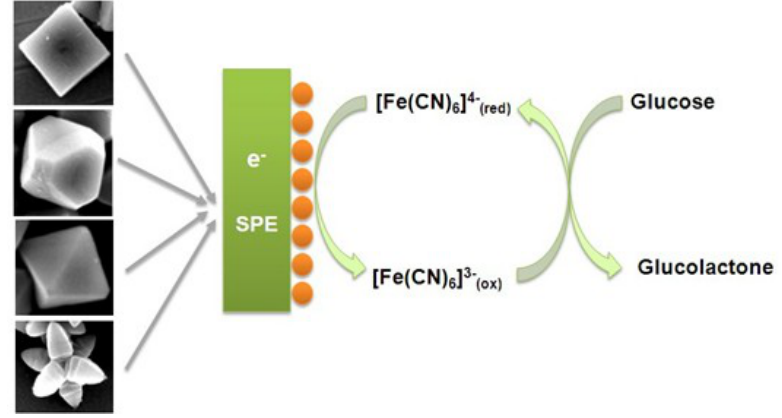
Figure 4. CVs of bare SPE and SPE with hexapod Cu